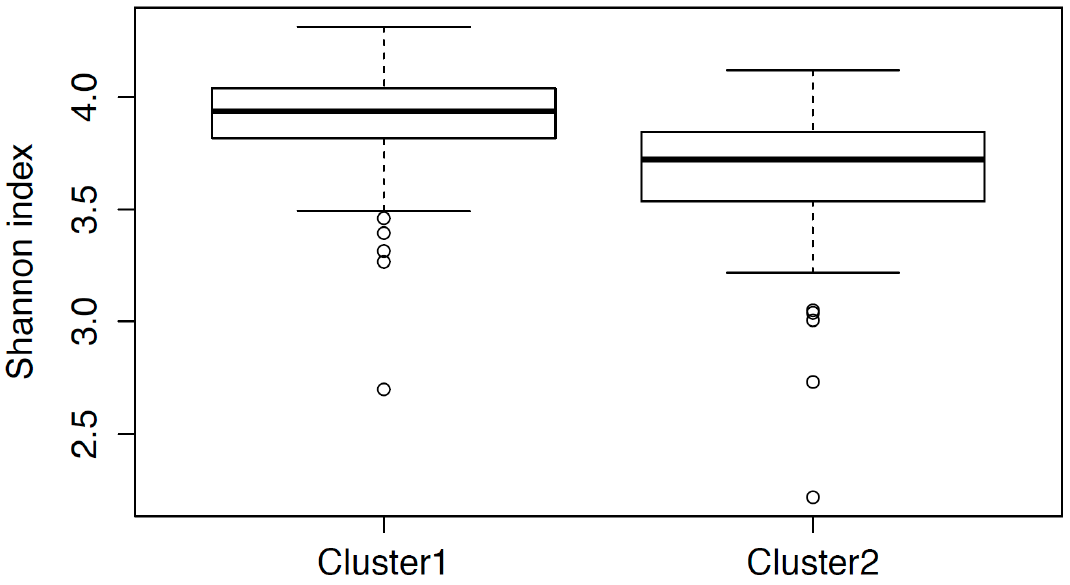
Figure 3. Distribution of alpha-diversity across the microbiota clusters.